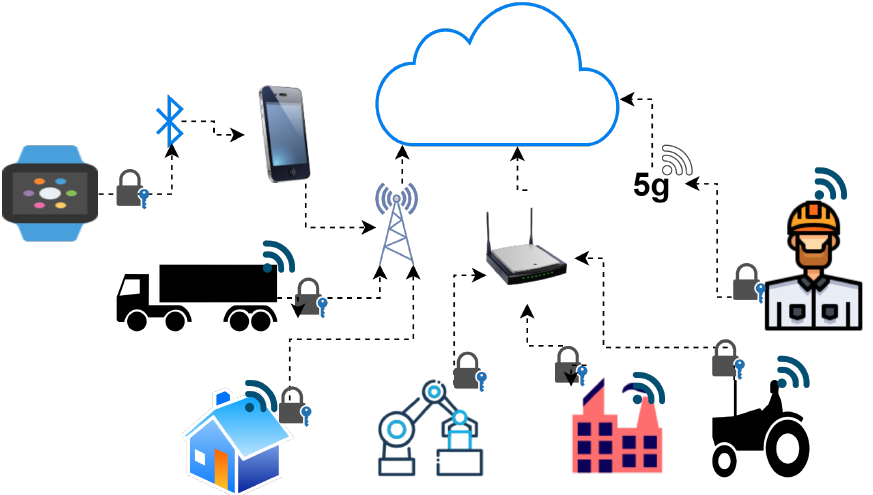
Figure 1. New technologies raised by the growth of industrialization and